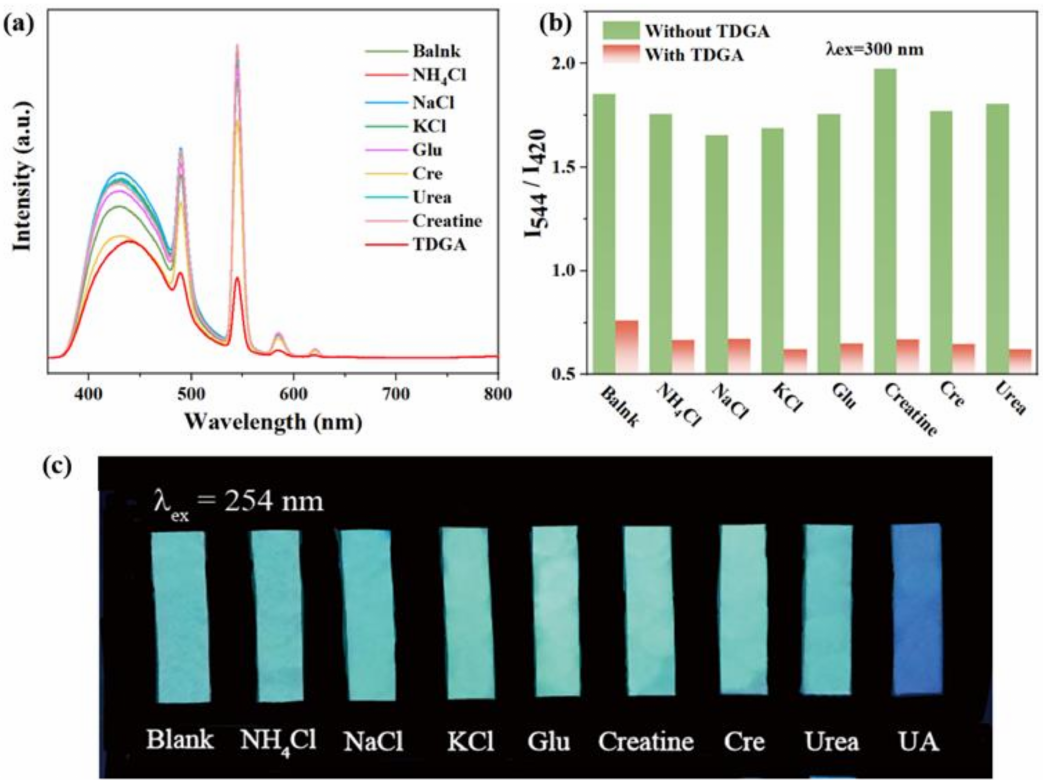
Figure 5. ( a ) Emission spectra of C460@Tb-UiO-66-(COOH) 2 with various constituents in human urine; ( b ) Anti-interference of C460@Tb-UiO-66-(COOH) 2 for detection of TDGA in the presence of different urine chemicals; ( c ) The photographs of C460@Tb-UiO-66-(COOH) 2 having various urine components under 254 nm UV light